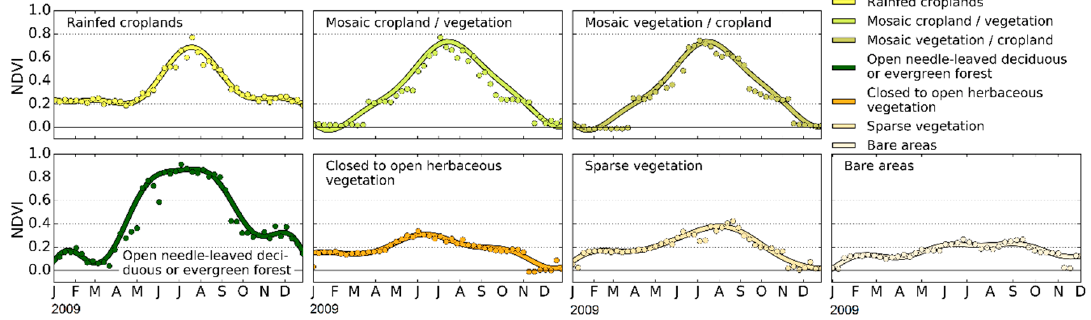
Figure 6. Accuracy assessment of time series reconstruction of NDVI using iHANTS for the seven dominant land cover types in the study region in northeastern China.